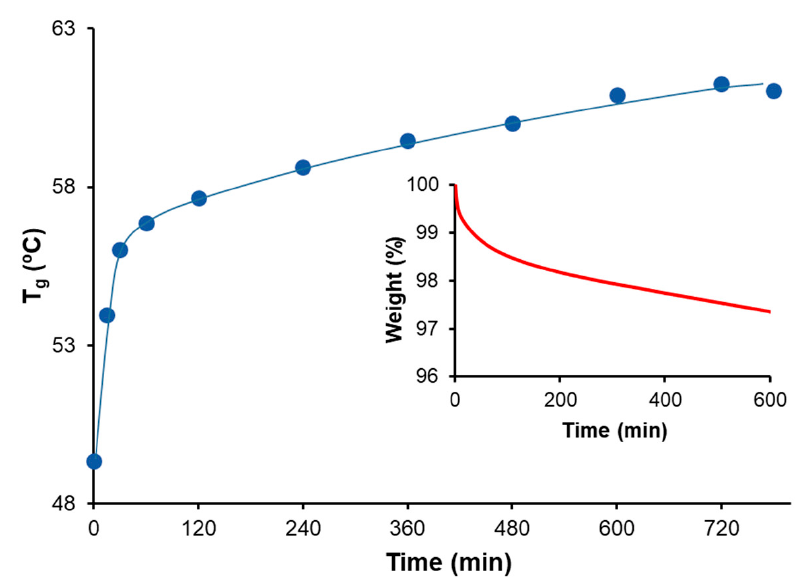
Figure 12. T g increase in FEMA 3D 25 as a result of structural changes in the network during treatment at 180 ◦ C. The TGA curve at this temperature is given as the inset.